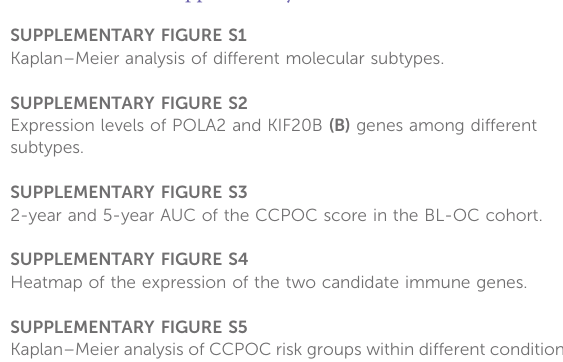
SUPPLEMENTARY FIGURE S4 Heatmap of the expression of the two candidate immune genes. SUPPLEMENTARY FIGURE S5 Kaplan – Meier analysis of CCPOC risk groups within different